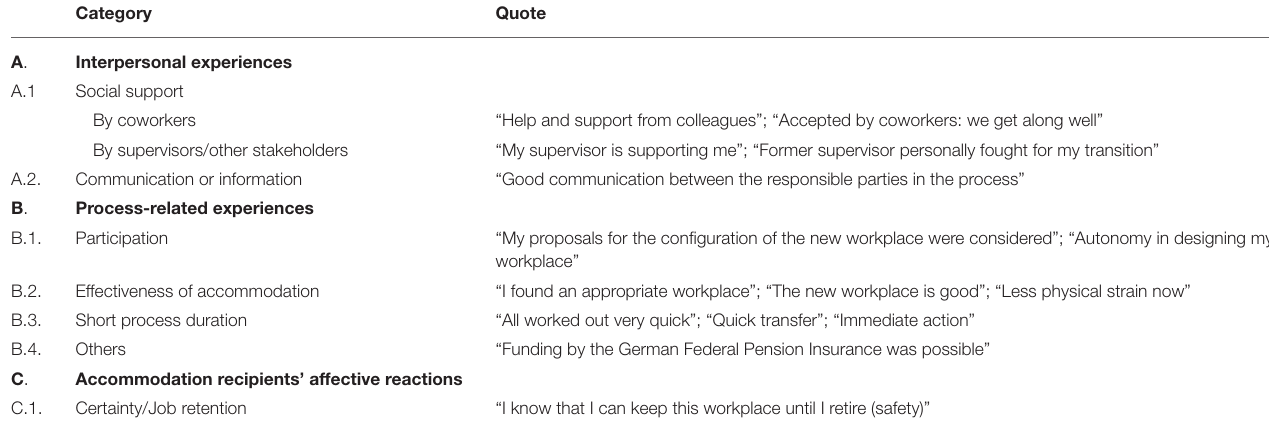
TABLE 4 | Quotes for recipients’ positive experiences. Category